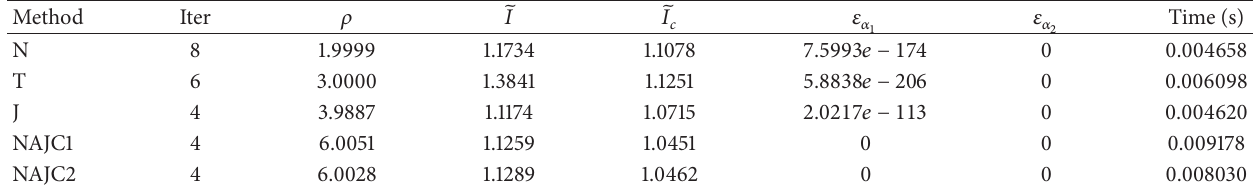
Table 5: Results of system (a), 𝑥 (0) = (4, −3) 𝑇 .